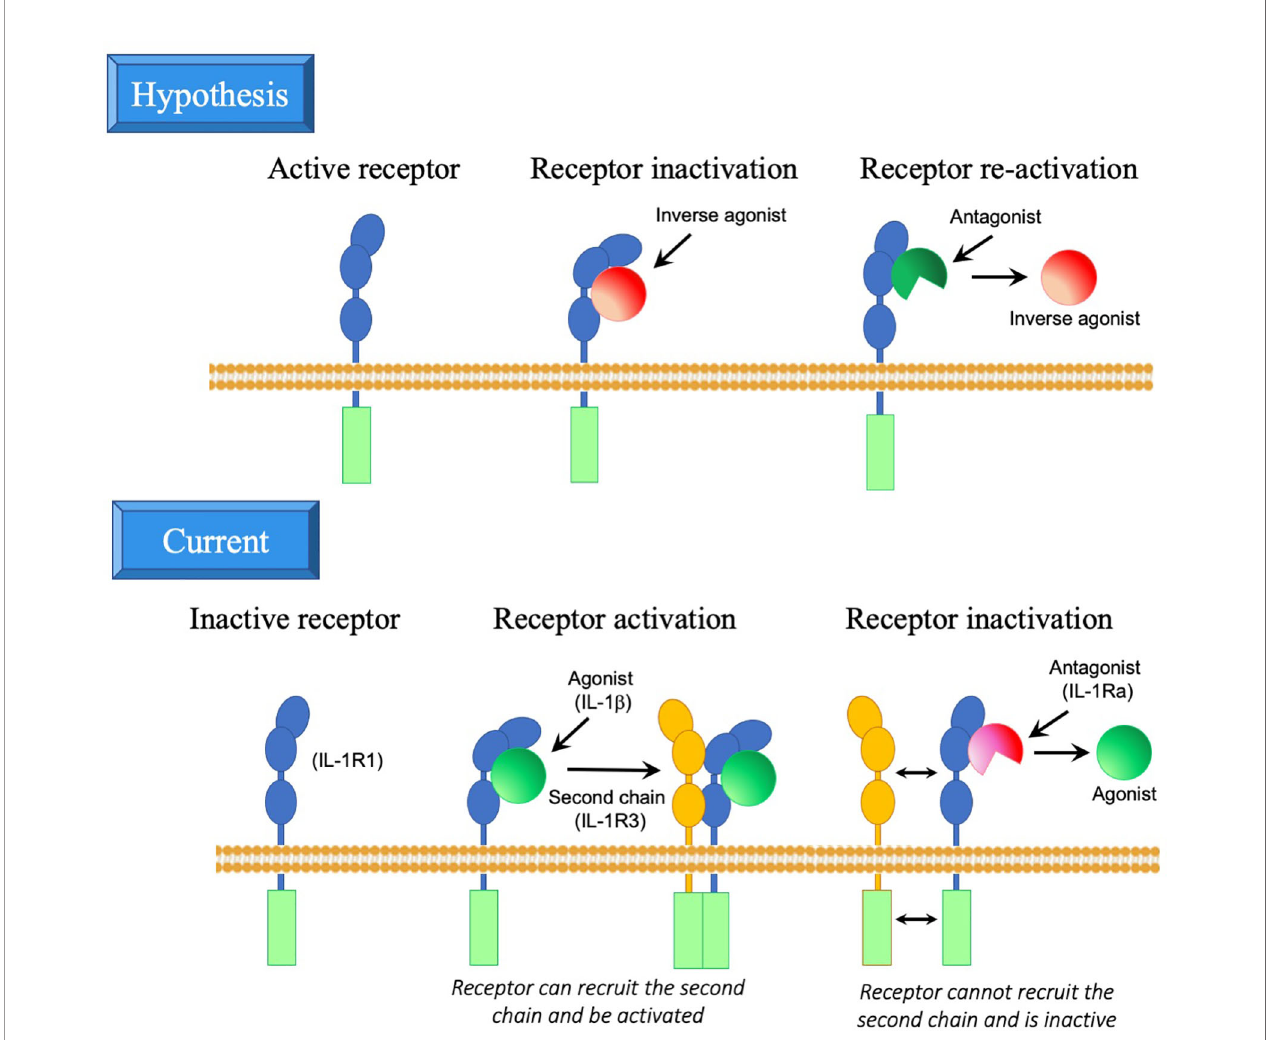
FIGURE 2 | Inverse agonist hypothesis in the development of IL-1R ligands. Upper panel. Hypothesis on the possible development of IL-1R family molecules and their ligands. The receptor may have developed as a molecule with intrinsic activity, in the absence of interaction with ligands (this is still the case for instance for the orphan receptor IL-1R9). Ligands may have developed as a tool for inhibiting and modulating the receptor activity (inverse agonists, which inhibit rather than activate the receptor), likely by changing the receptor conformation. Consequently, antagonists may have developed as partial ligands, based on modi fi cations of the inverse agonist structure, that bind to the receptor and displace the inverse agonists, while unable to modify the receptor conformation and its activity. Lower panel. Current model of IL-1R and ligand interaction. The receptor is intrinsically inactive (for instance, in the case of IL-1R1). Binding of an agonist (such as IL-1 b ) changes the receptor conformation thereby enabling the interaction with a second chain (such as IL-1R3) and consequent activation (by approximation of the intracellular domains of the two receptors). Antagonists (such as IL-1Ra) have a similar structure as agonists and are able to partially bind to the receptor, thereby displacing the agonist, but unable to modify the receptor conformation and thus preventing interaction with the second chain and consequent activation. Artwork by W.J. Yang